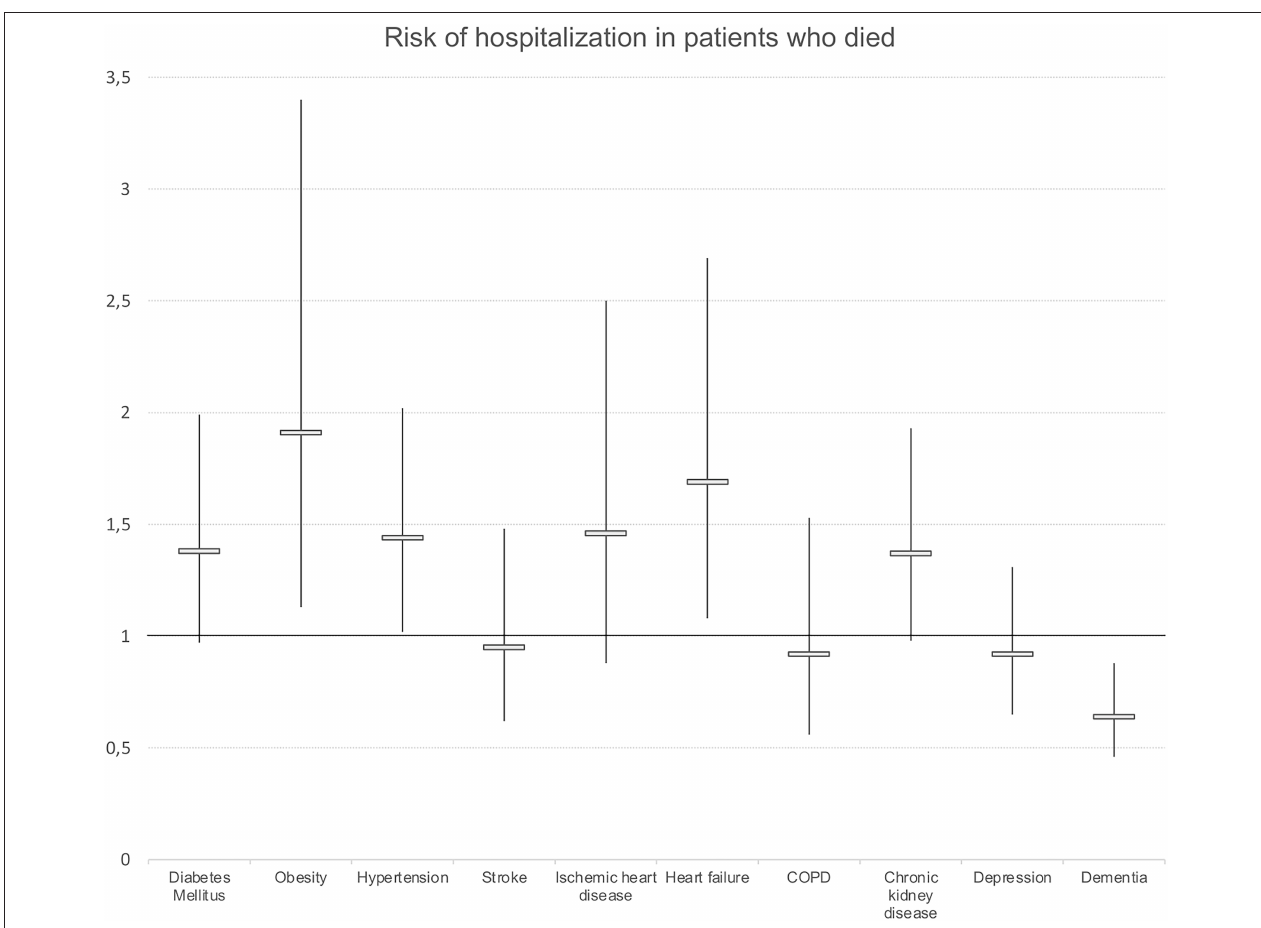
FIGURE 4 | Presence of chronic morbidity and risk of hospitalization in those who died at 90 days. regression models. Odds ratios and 95%Confidence intervals. Results adjusted by sex, age and socioeconomic level. COPD, chronic obstructive pulmonary